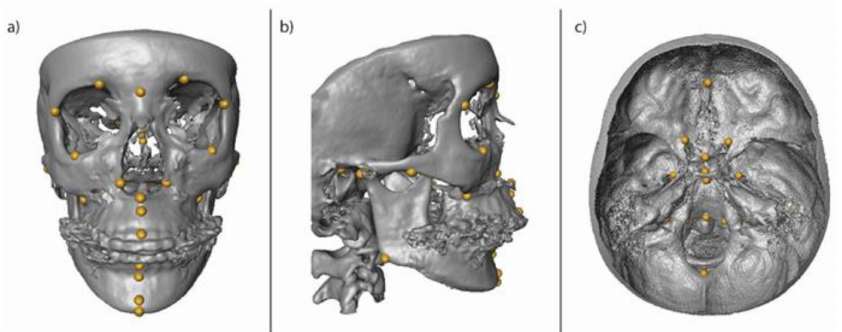
Figure 1. Volume rendering of a 3D skull in a frontal ( a ), lateral ( b ), and axial section ( c ) view of the cranial base, including the anatomical landmarks that were annotated on the CBCT images and used for the morphometric analysis. Each landmark is indicated by a yellow dot [55]. The list of landmarks can be found in Supplementary Table